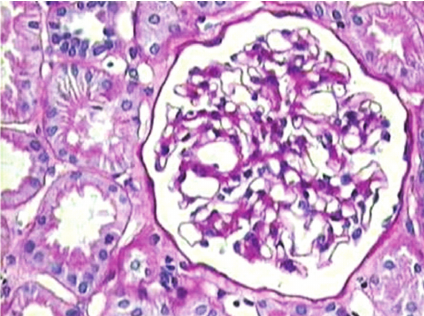
Figure 3: Medium-power view showing a glomerulus with mild mesangial prominence, but no significant increase in mesangial hypercellularity. This case latter turned out to be IgM nephropathy after IF showed di ff use granular mesangial positivity of IgM, as shown in Figure 4. (PAS stain, × 200).